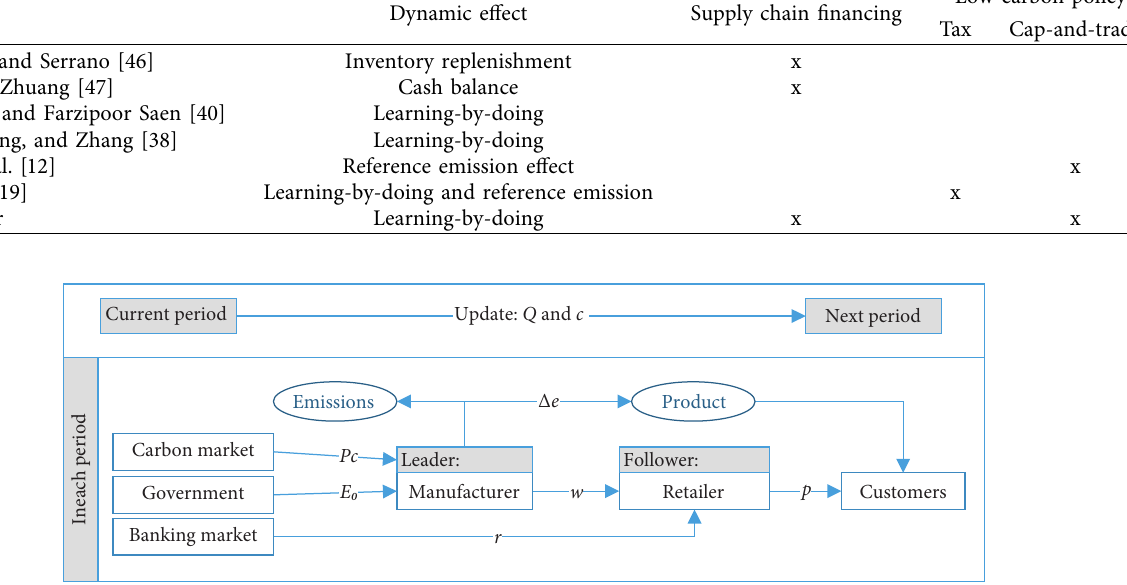
Figure 1: Supply chain